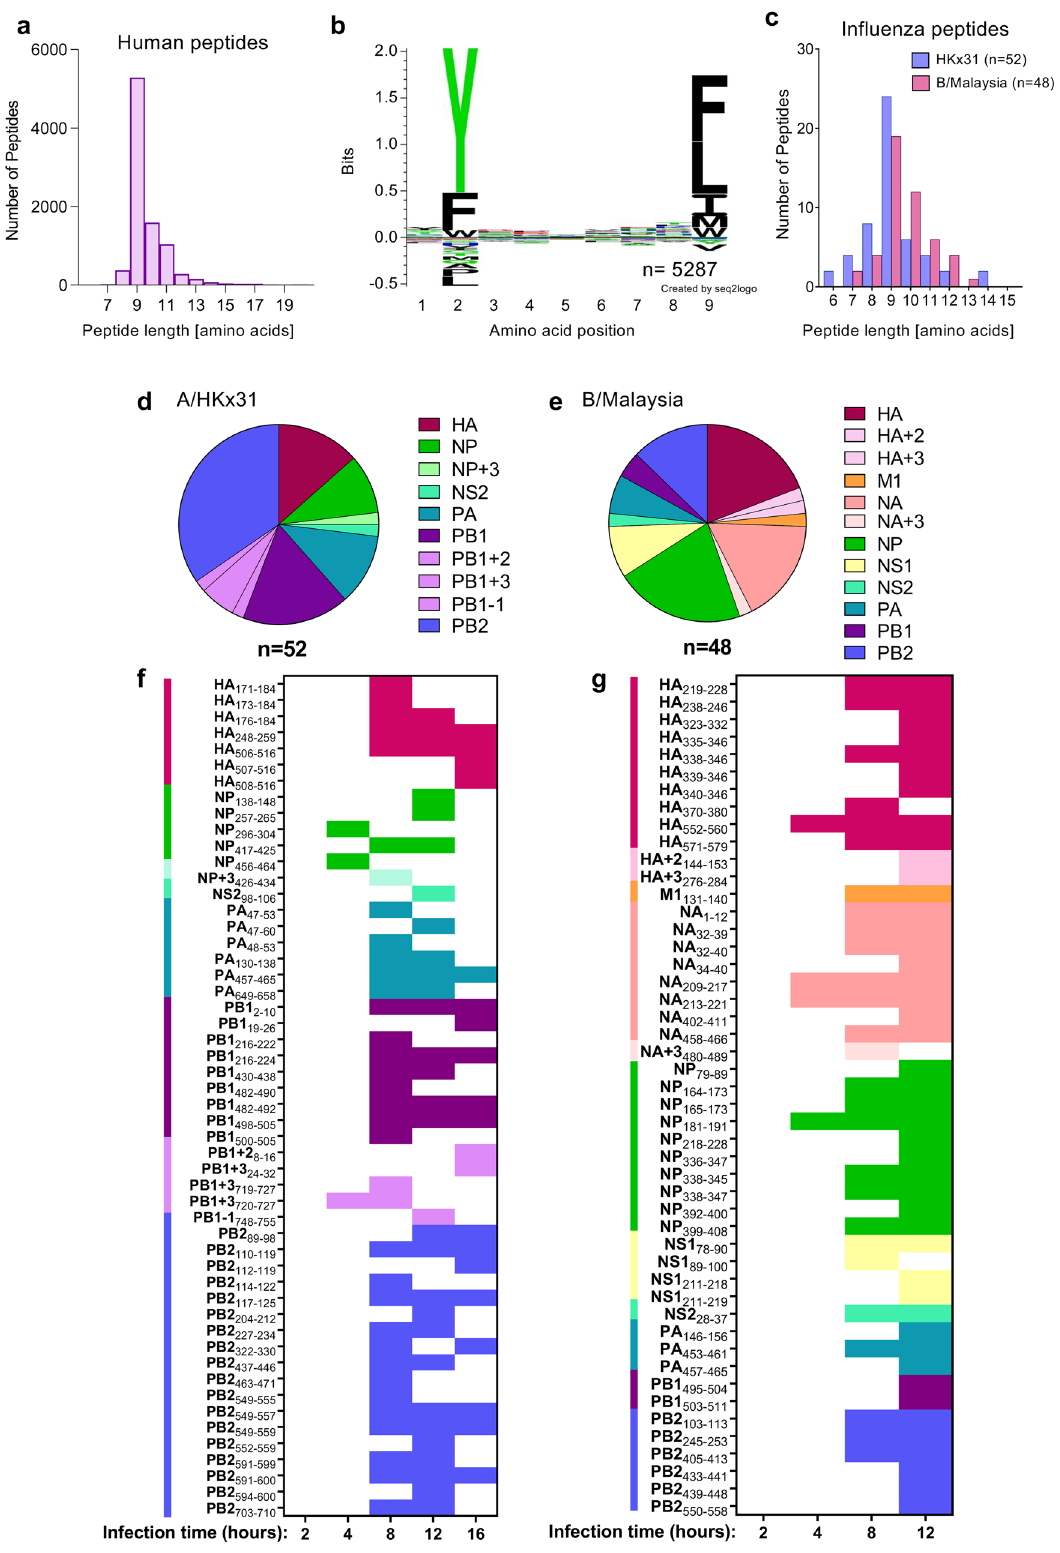
subsequent screening (Supplementary Tables 2, 3 and Supplemen- similar fragmentation patterns and retention times to the discovery data, supporting the original identi fi cations (Supplementary Data